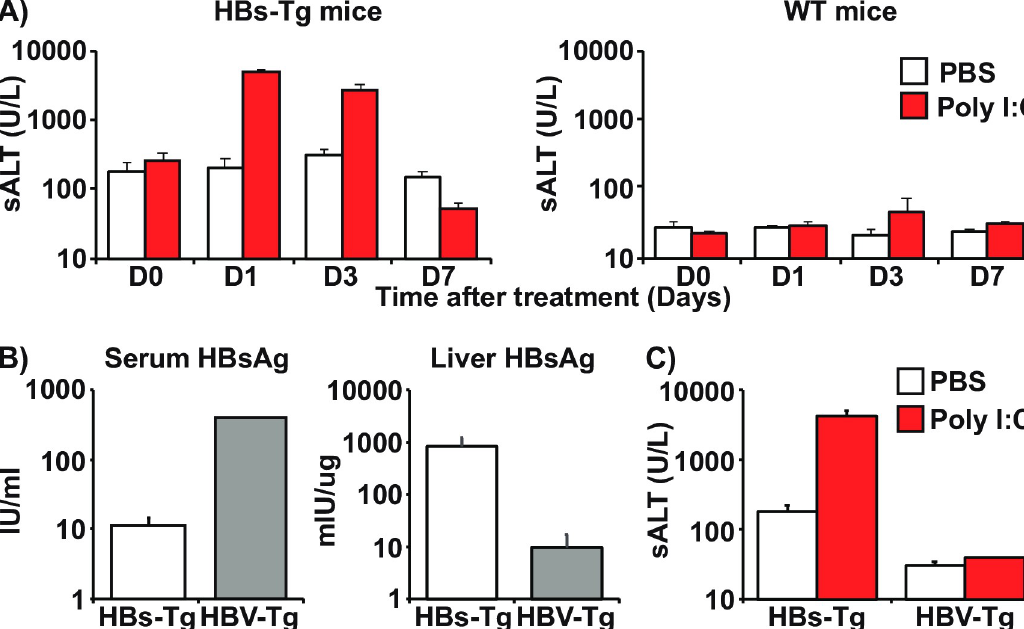
Fig 1. Poly I:C induces liver injury in association with HBsAg-retention. (A) Serum ALT levels measured on days 0, 1, 3, and 7 after PBS (white bars) or poly I:C (10 μ g) (red bars) treatment in HBs-Tg mice (left graph) and WT mice (right graph). (B) Comparison of HBsAg expression levels between HBs-Tg (Lineage 107-5D: white bars) and HBV-Tg mice (Lineage 1.3.32: grey bars) in the serum (left graph) and the liver (right graph). (C) Serum ALT levels in HBs-Tg mice and HBV-Tg mice 24 hours after intravenous injection of PBS or poly I:C. Mean values +/- s.d of pooled data from 3 independent experiments are shown.